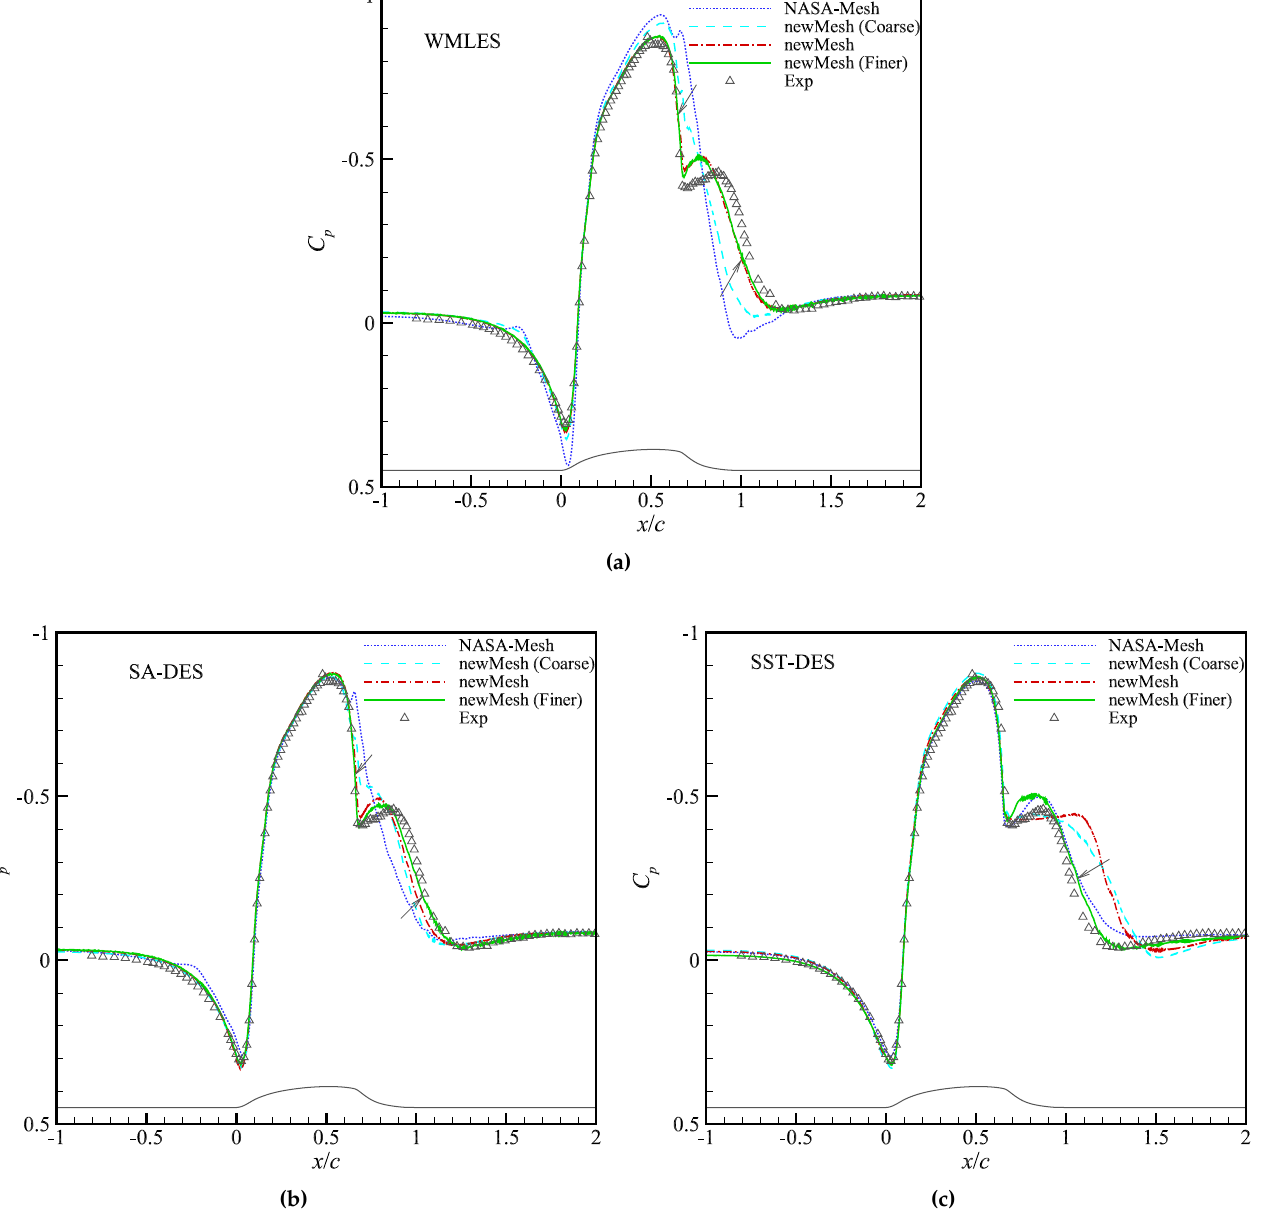
Figure 10. Mean pressure distributions obtained by ( a ) WMLES, ( b ) SA-DES and ( c ) SST-DES based on different